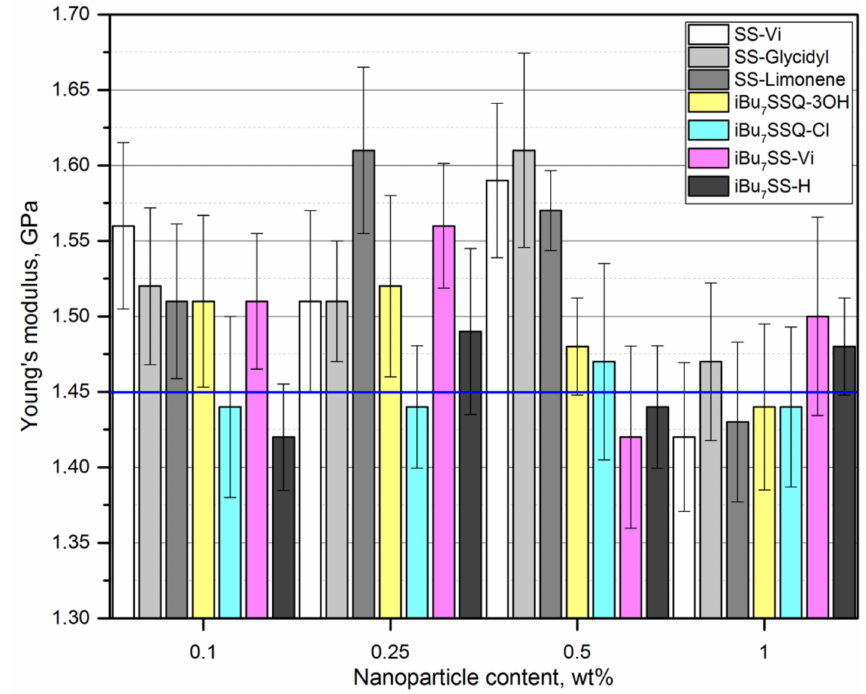
Figure 7. Young’s modulus of the CS/iPP